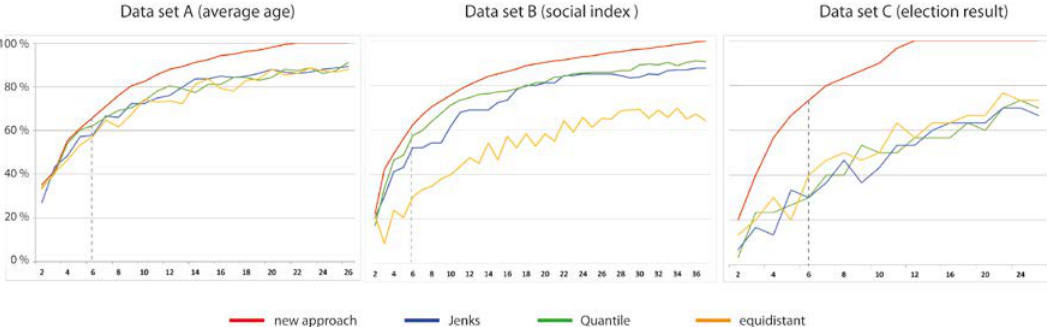
Figure 5. Better preservation of polygons with local extreme values using the proposed approach (red line) compared to conventional methods—the right axis shows number of classes, the upper axis shows